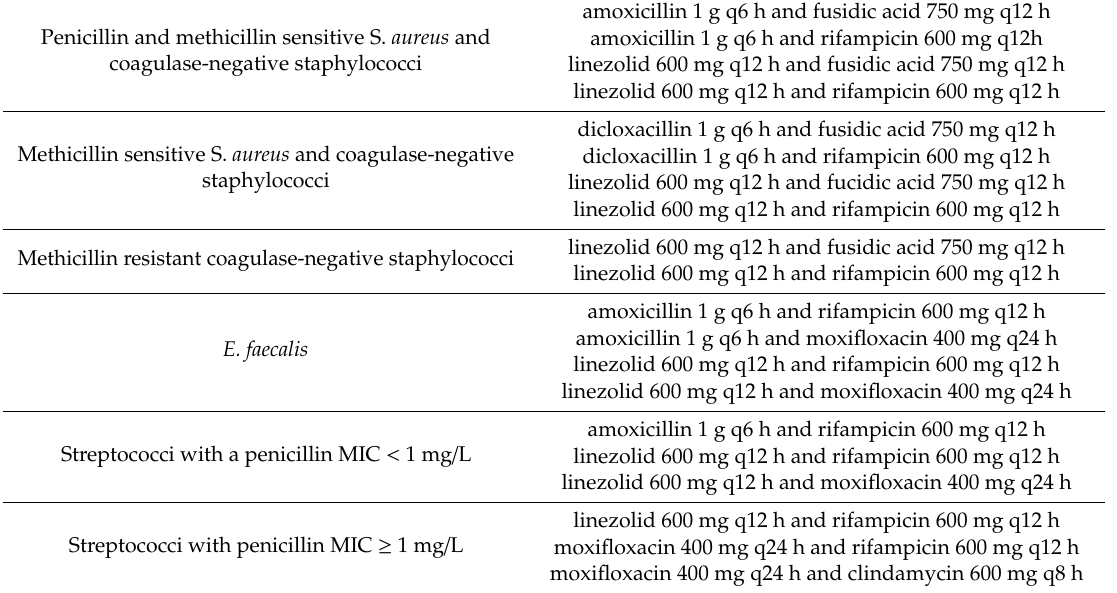
Table 2. Oral antibiotic regimens adopted in the Danish trial [18]. Penicillin and methicillin sensitive S. aureus